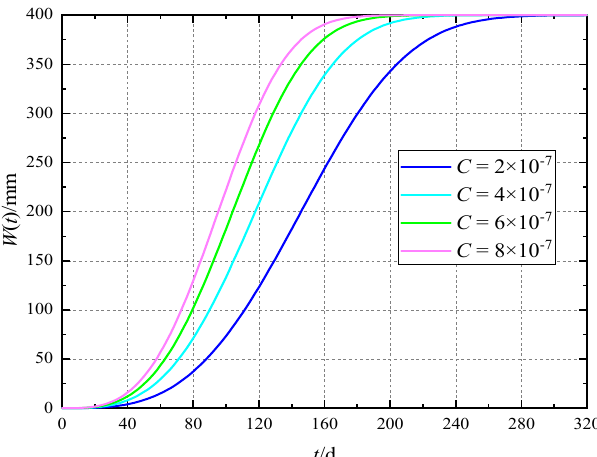
Figure 5. The surface subsidence curve with different time influence parameter C . Comparing Figures 2 and 5, it can be seen that the impact of time influence parameter C on the surface subsidence curve is similar to the model order n , both of which have no e ff ect on the initial and final surface subsidence values, but only a ff ect the time to reach the final subsidence value. The larger C is, the less time it takes for the surface subsidence to reach a stable state. When the model n is determined, the key to the improved time function model accuracy is the determination of C